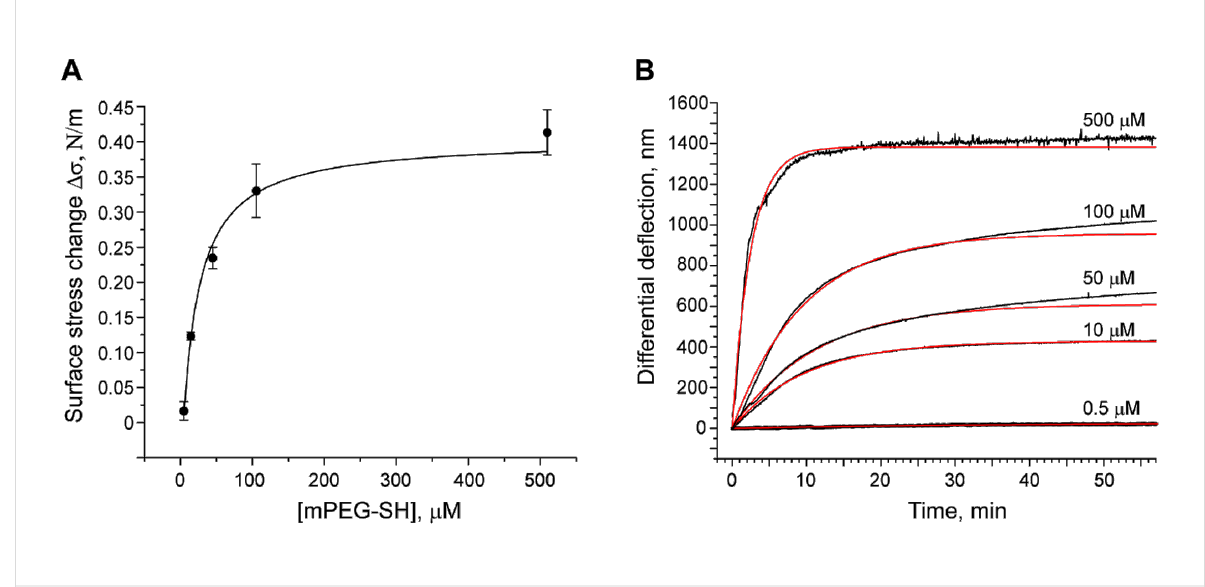
Figure 4: (A) Adsorption isotherm of mPEG–SH on Au. Each point (circle) corresponds to the maximum differential signal observed at the following mPEG–SH concentrations: 0.5, 10, 50, 100 and 500 μ M. The solid line represents the Langmuir isotherm fitting curve (R 2 = 0.982). (B) Represen- tative plots of microcantilever deflection versus time. Kinetic curves (black) were fitted using the exponential Langmuir rate law (red). The curves were fitted for the first 30 min of the binding event and then extrapolated for a longer period of time.